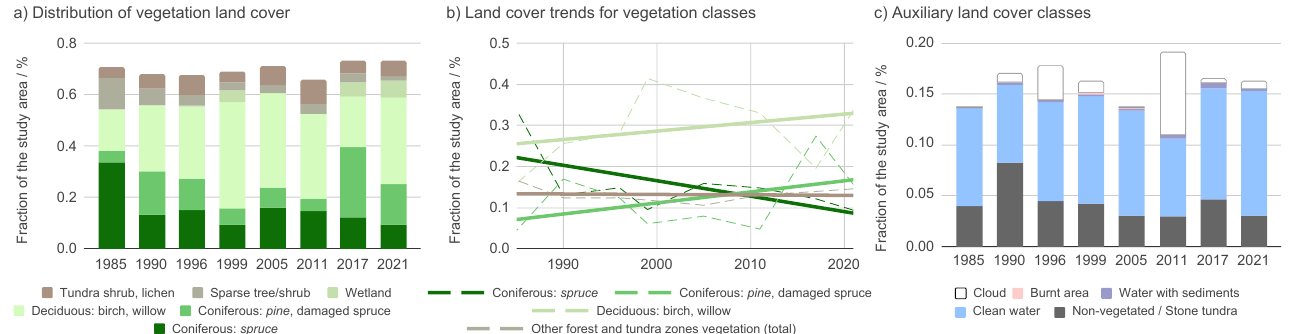
Figure 11. Relative coverage of land cover classes over time for ( a ) dominant classes and ( b ) their fitted trends over time, ( c ) auxiliary and non-vegetated